Question: Which visualization type does this figure use?
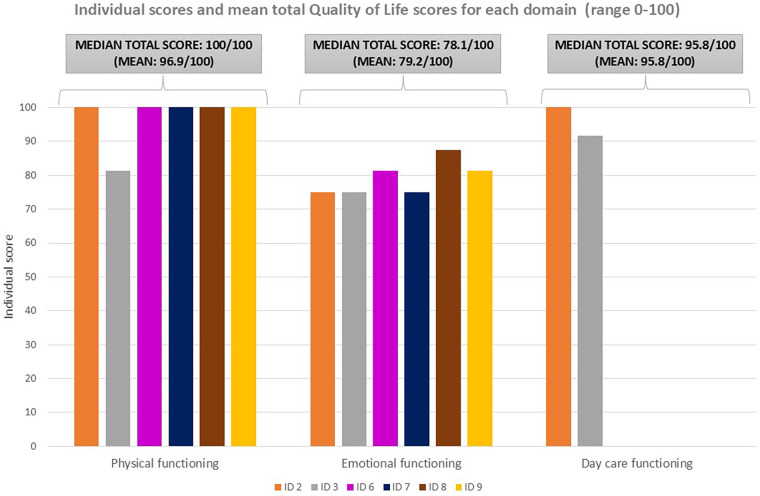
Answer: bar